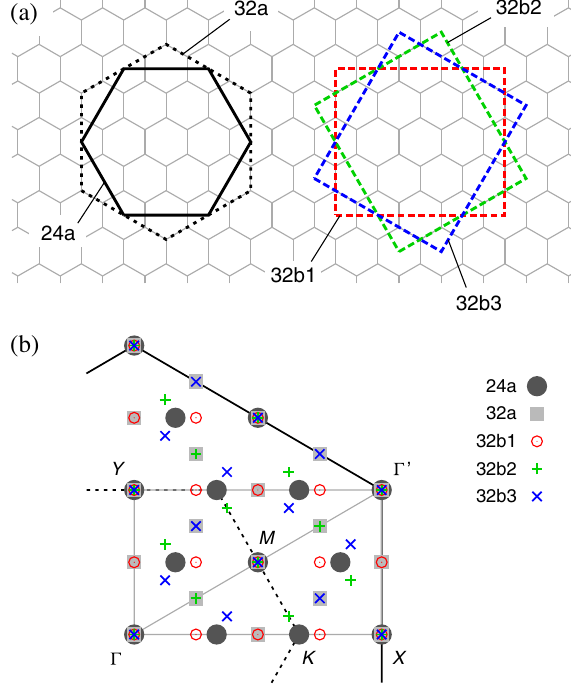
FIG. 8. (a) Clusters used in the exact diagonalization calcu- lations: fully symmetric hexagonal 24- and 32-site clusters and a rectangular 32-site cluster in three possible orientations with respect to the honeycomb lattice. (b) Wave vectors compatible with periodic boundary conditions applied to the individual clusters. They are shown in one quadrant of the first Brillouin zone of the honeycomb lattice (dashed black line) and that of the completed triangular lattice (solid black line). High-symmetry points and the path along which the measured or simulated data are presented (gray line) are indicated [cf. Fig.